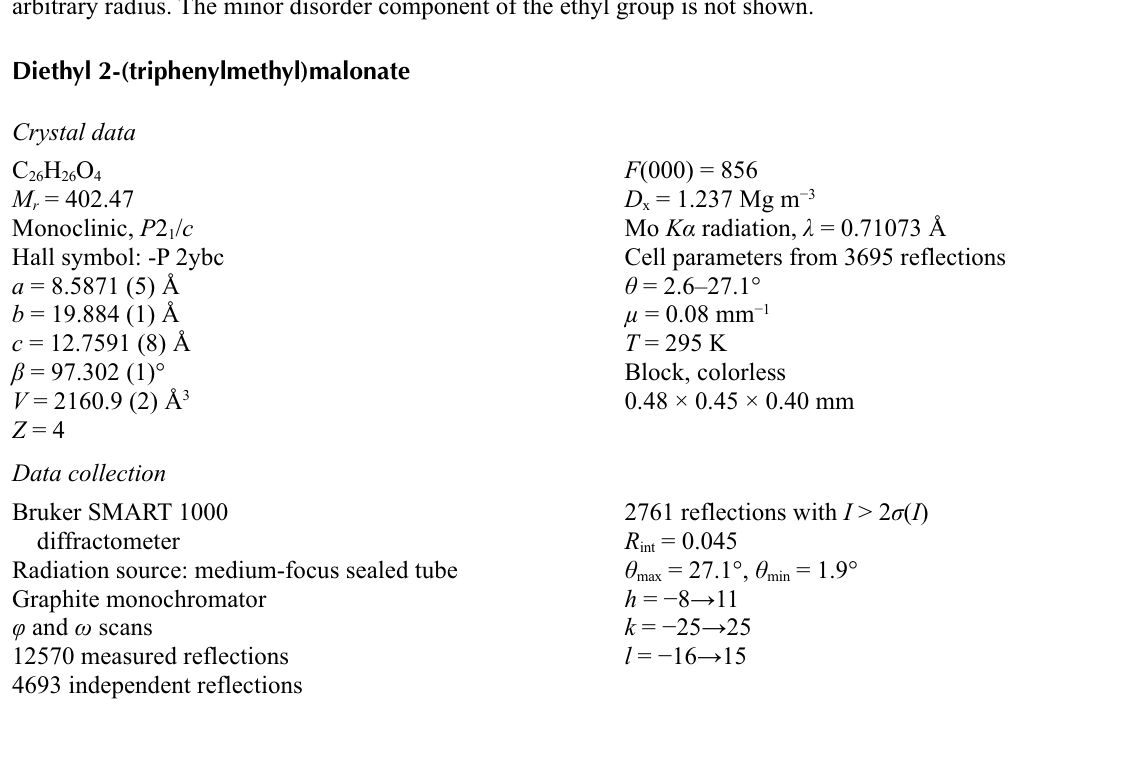
Figure 1 Thermal ellipsoid plot (Barbour, 2001) plot of at the 50% probability level. Hydrogen atoms are drawn as spheres of arbitrary radius. The minor disorder component of the ethyl group is not